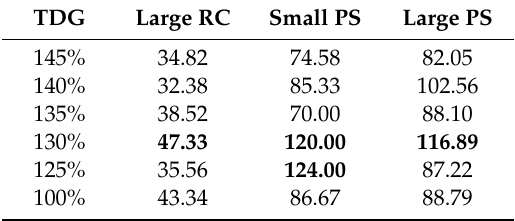
Table 4. Comparison of CAT activity between treatment fish and control fish. Bold numbers indicate that the enzymatic activity of this group was higher than that of the control